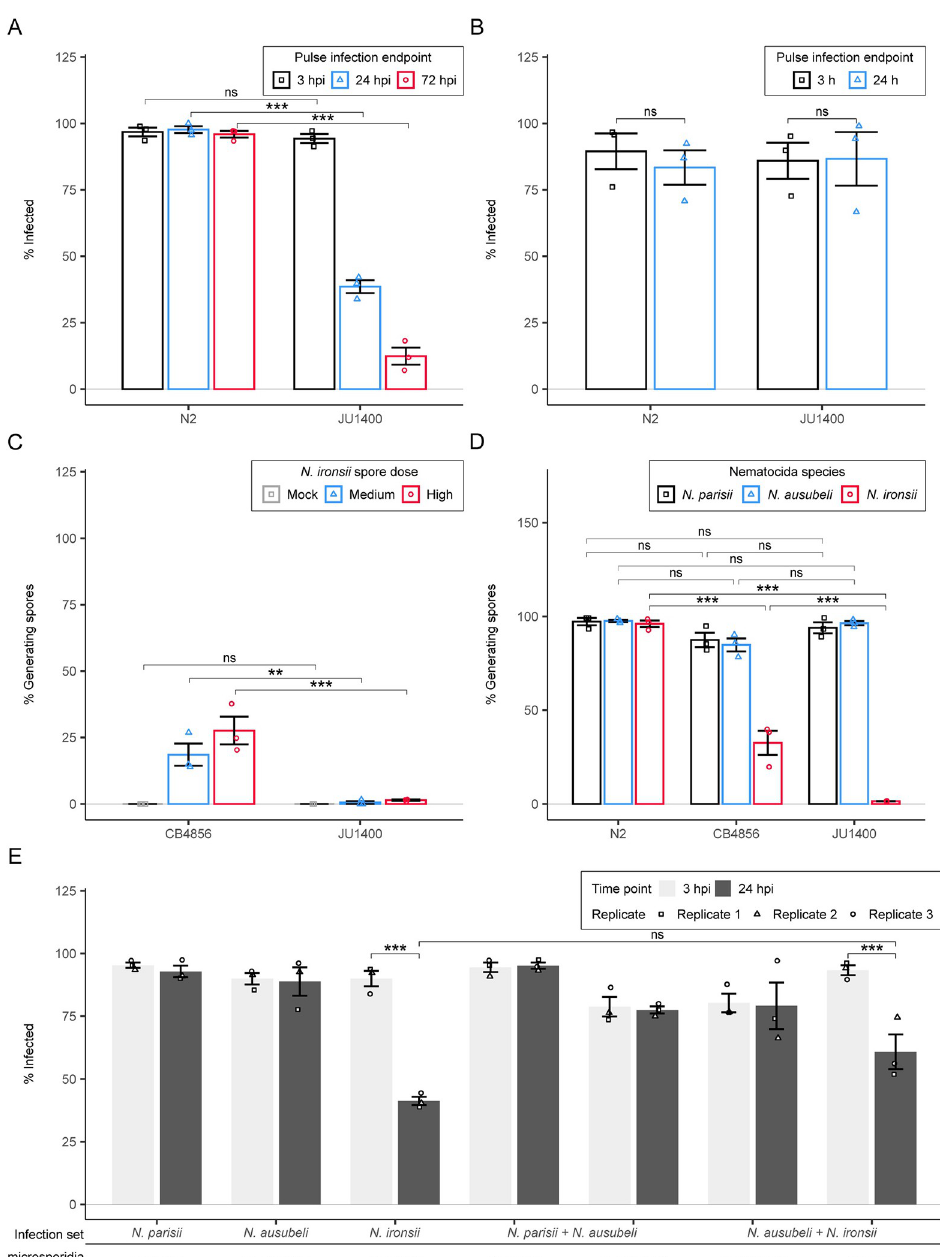
Fig 5. JU1400 specifically clears N . ironsii infection at the earliest larval stage. (A-B) N2 and JU1400 animals were pulse infected for 3 hours with N . ironsii before washing away excess spores. Animals were pulse infected at either the L1 stage and fixed at 3-, 24-, and 72 hpi (A) or animals were pulse infected at the L4 stage before fixing at 3- and 24 hpi (B). Samples were then stained with an N . parisii 18S RNA FISH probe and animals containing either sporoplasms or meronts were counted as infected. Bar plot with SEM bars show percent of animals infected per replicate from three biological replicates with n = 20 worms per replicate. (C) CB4856 and JU1400 were infected at the L1 stage with either medium or high doses of N . ironsii for 72 hours and then fixed and stained with DY96. (D) N2, JU1400, and CB4856 were infected at the L1 stage with either N . parisii , N . ausubeli , or N . ironsii for 72 hours and then fixed and stained with DY96. (C-D) Bar plot with SEM bars show percent of animals generating spores per replicate from three biological replicates with n = 20 worms per replicate. (E) JU1400 animals were pulse infected for 3 hours with N . parisii , N . ausubeli , N . ironsii , N . parisii + N . ausubeli , or N . ausubeli + N . ironsii before washing away excess spores. Animals were either fixed immediately at 3 hpi or at 24 hpi. Samples were then stained with species-specific 18S rRNA FISH probes and animals containing either sporoplasms or meronts were counted as infected. Bar plot with SEM